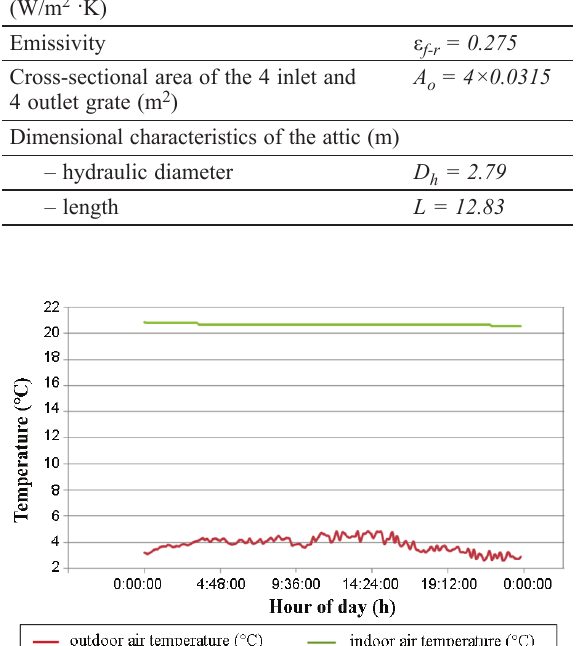
Table 2. Some data from comparative thermal calculations of the attic (Zender-Swiercz, Piotrowski 2010) Heat exchange coefficient from the indoor air to the attic floor surface (W/m 2 ·K)